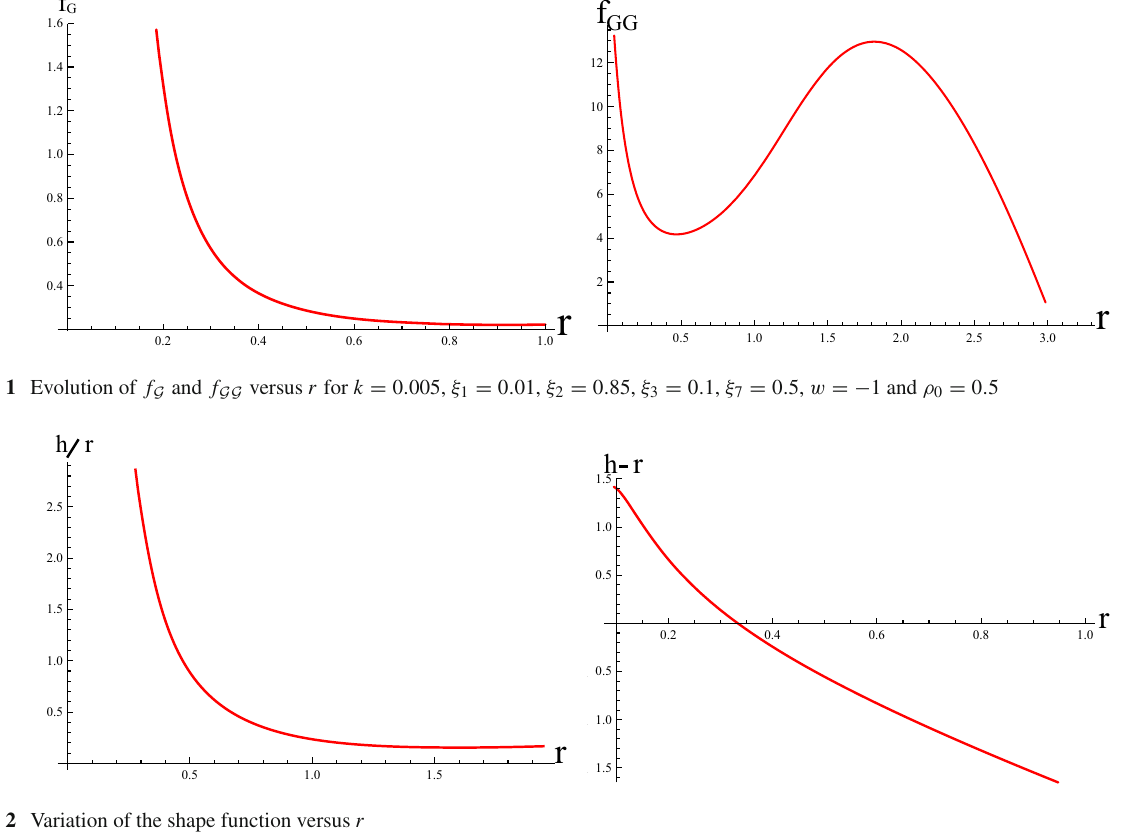
Fig. 2 Variation of the shape function versus r